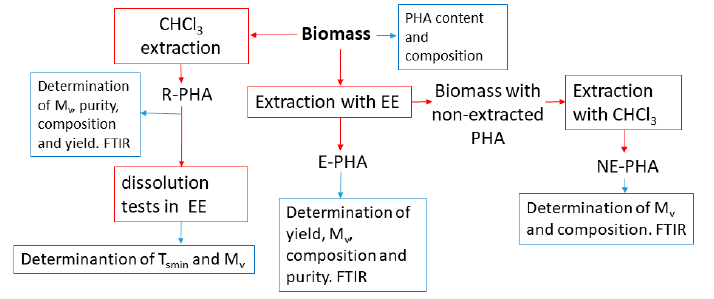
Figure 2. Block diagram of the sample transformations (red lines) and characterizations (blue lines).